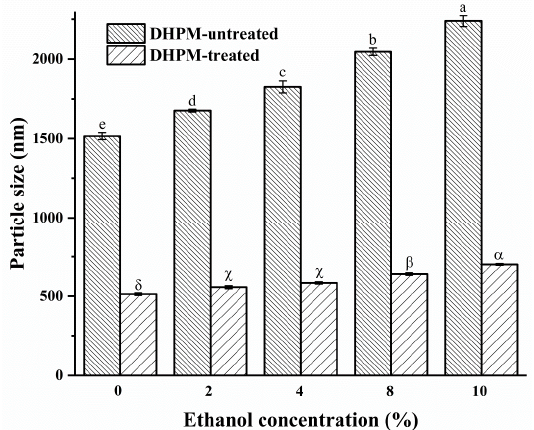
Figure 1. Average particle size of pectin treated with or without DHPM under different ethanol concentrations (error bars represent the standard deviation of three replicates). Different letters (a, b, c, . . . ) for DHPM-untreated samples indicate significant differences (Tukey’s test, p < 0.05). Different Greek letters ( α , β , γ , . . . ) for DHPM-treated samples indicate significant differences (Tukey’s test, p < 0.05).